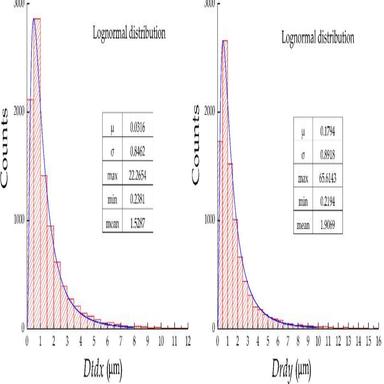
2D grain size distributions.